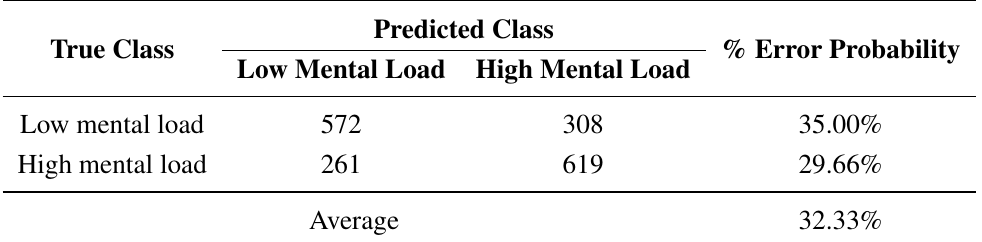
Table 5. Confusion matrix and percentage of classification error (error probability) for each class using a maximum number of 80,000 operations per second ( N particularized for Analysis 3: mental